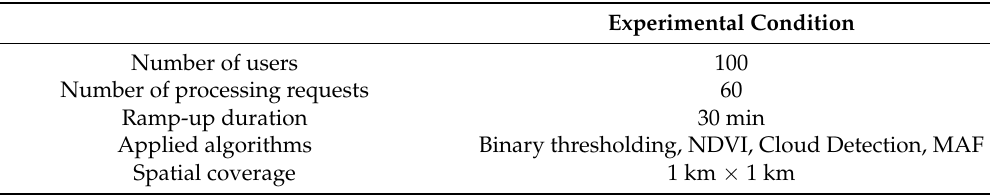
Table 2. Summary of the auto-scaling